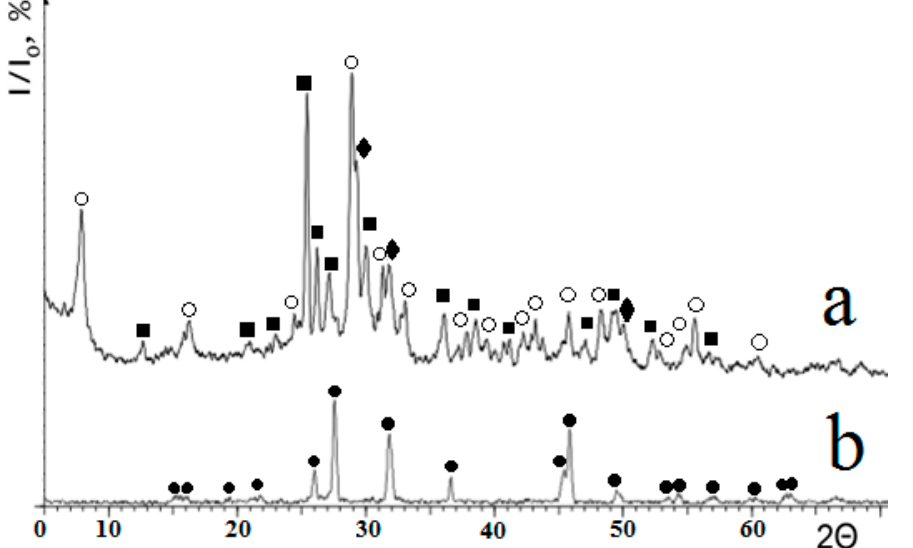
Figure 3. X-ray diffraction patterns of calcium silicate samples: ( a )—initial CaSiO 3 sample after autoclave synthesis; ( b )—after annealing at 1200 °C for 5 hours. Phase designation: ○ -tobermorite 9A Ca 4 Si 6 O 15 (OH) 2 ·5H 2 O; ■ —wollastonite CaSiO 3 ; ♦ —calcium hydrosilicate Ca 1,5 SiO 3,5 ·xH 2 O; ● — pseudowollastonite CaSiO 3.